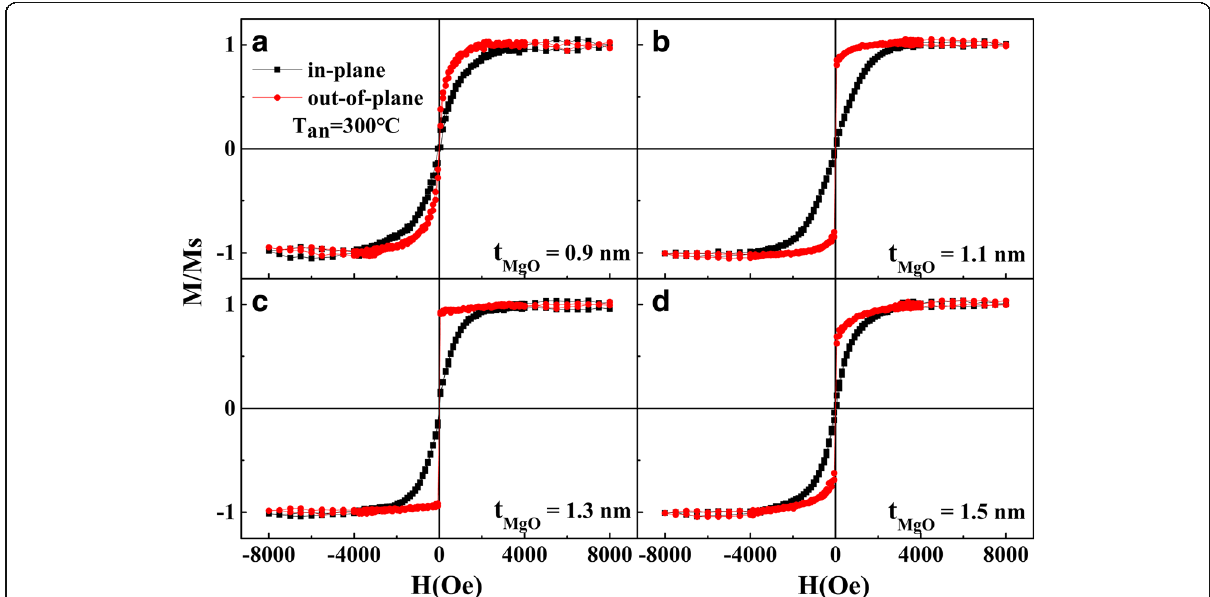
Fig. 1 In-plane and out-of-plane M-H loops of Ta/Pd/CFMS (2.3 nm)/MgO ( t MgO )/Pd annealed at 300 °C. a t MgO = 0.9 nm. b t MgO = 1.1 nm. c t MgO = 1.3 nm. d t MgO = 1.5